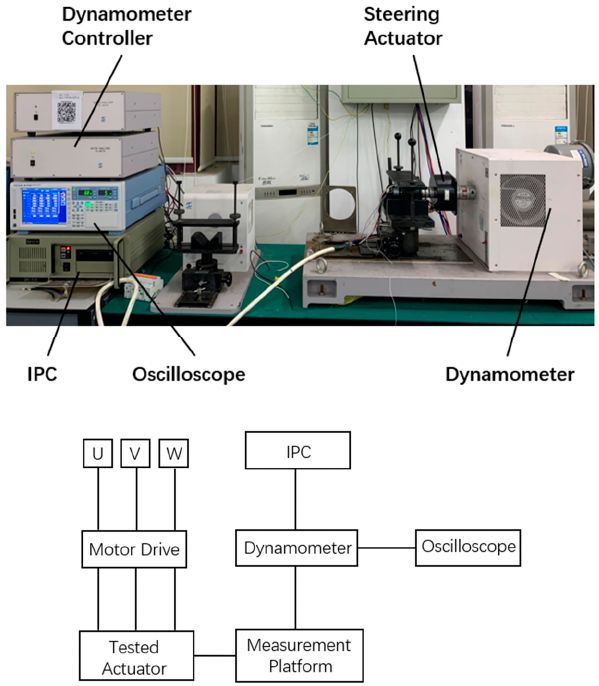
Figure 5. Power measurement of the OMR’s actuator.